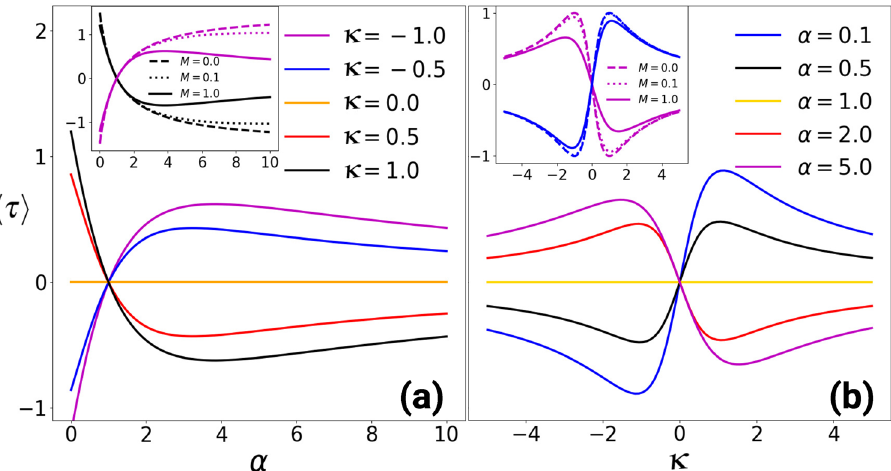
Figure 2. Average exerted torque by the magneto-gyrator as a function of ( a ) the parameter α for different values of κ ( b ) diffusive Hall parameter κ for different values of α with T h = 4 T c = 4.0 . The main figures show the results for M = 1.0 while the insets depict those for M = 0.1 and M = 0.01 where M = km /γ 2 . ( a ) shows that the average torque has a maximum for an optimal value of α if the mass is sufficiently large. The maximum can be tuned by the applied magnetic field. As shown in ( b ), the average torque from Eq. (4) shows a maximum at an optimal κ , which can be reversed by the applied magnetic field. In addition, there is no torque if α = 1 or κ = 0 , which corresponds to the stalled